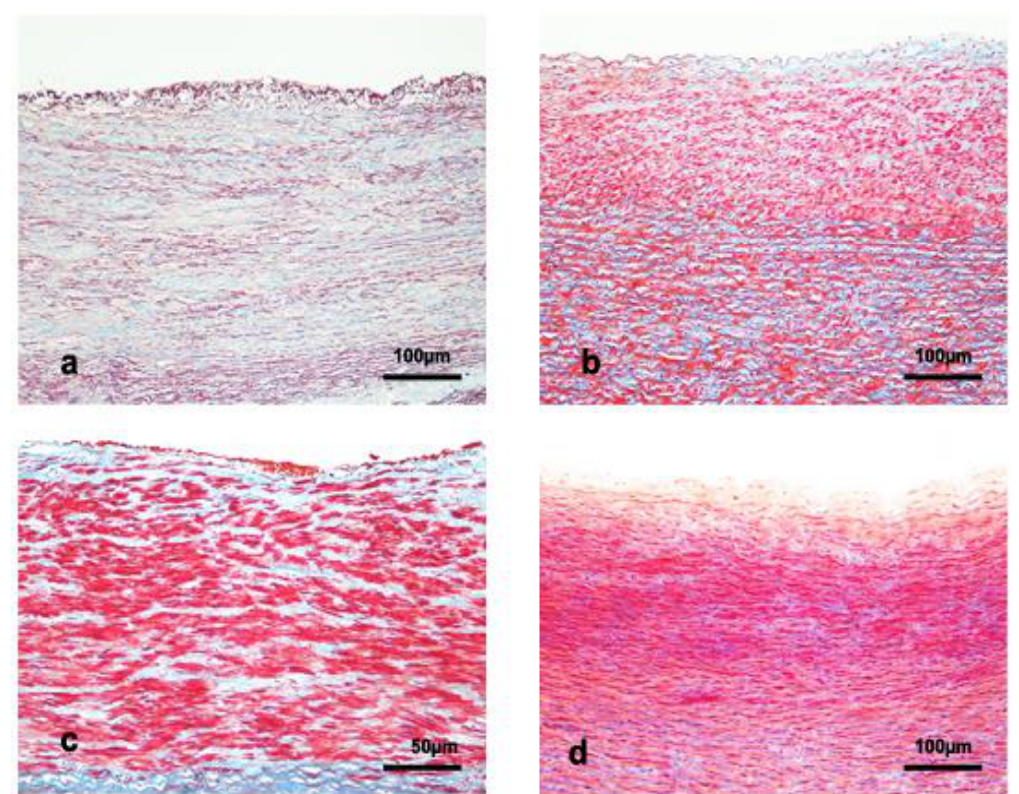
Figure 4. Abdominal aorta section (orcein and trichrome staining) of ( a ) adult female Mesoplodon densirostris (orcein staining), ( b ) juvenile female Kogia breviceps , ( c ) adult male Mesoplodon densirostris , and ( d ) calf female Grampus griseus . The red color indicates the smcs in ( b – d ), light pink in ( a ); the blue color indicates connective tissue, and the orange-violet color indicates the elastic fibers.